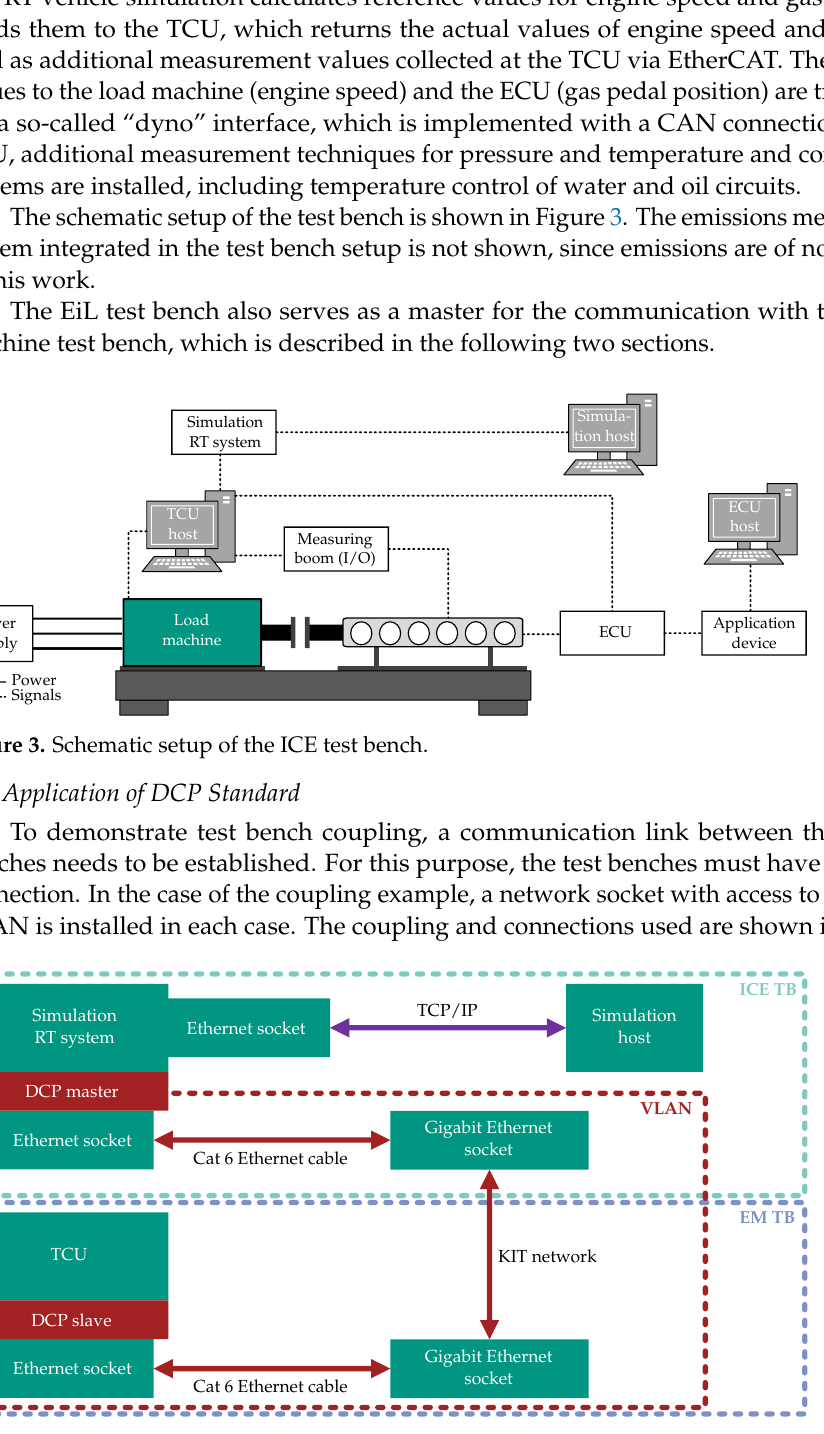
Figure 4. Network setup for test bench coupling